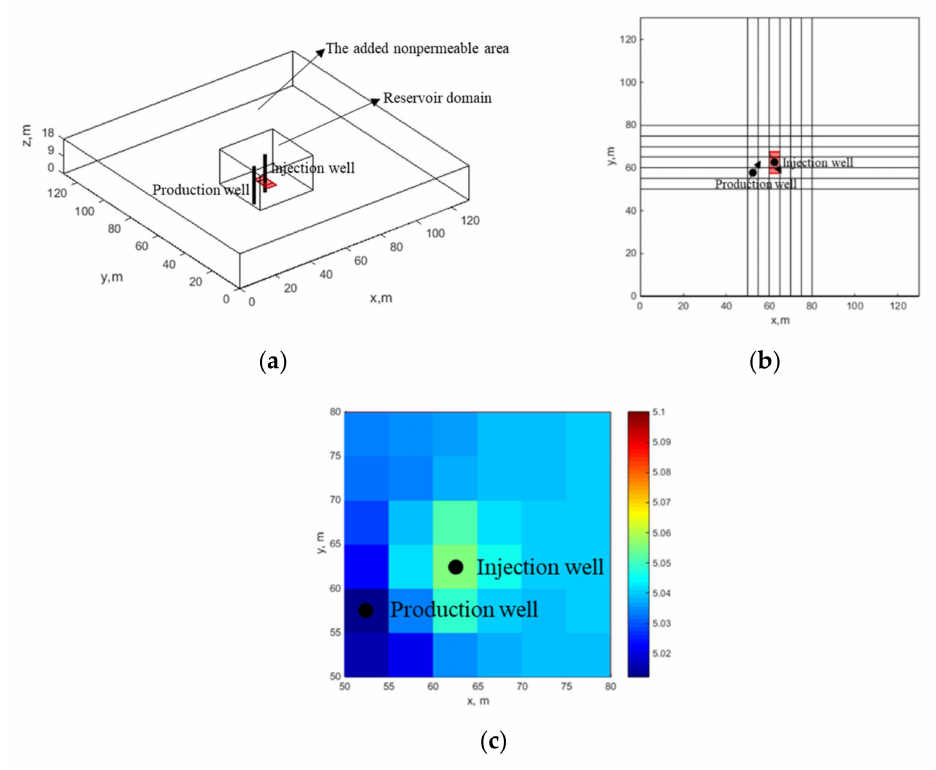
Figure 10. Geometric view of the reservoir model. ( a ) The 3D view; ( b ) 2D view; ( c ) a pressure profile.